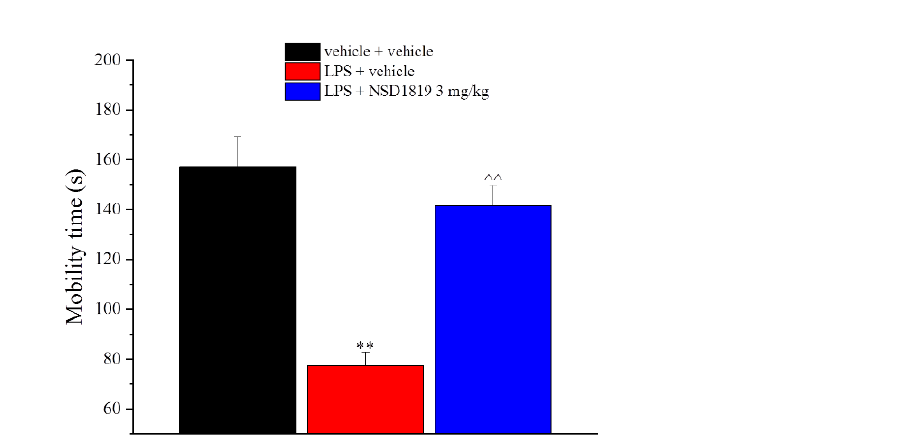
Figure 4. Effect of NSD1819 on LPS-induced depressive-like behavior. LPS (1 mg/kg) was intraperitoneally injected for five consecutive days (from 1 to 5). NSD1819 was suspended in 1% carboxymethylcellulose sodium salt (CMC) and daily orally administered starting from day 1 until the end of the experiment. Control animals were treated with vehicles. On day 8, 16 h after the last administration of the compound, the depressive-like behavior was assessed by the Porsolt test. Data are expressed as the mean ± S.E.M. of values from 8 mice analyzed in 2 different experimental sets. ** p < 0.01 vs. vehicle + vehicle; ^^ p < 0.01 vs. LPS + vehicle.